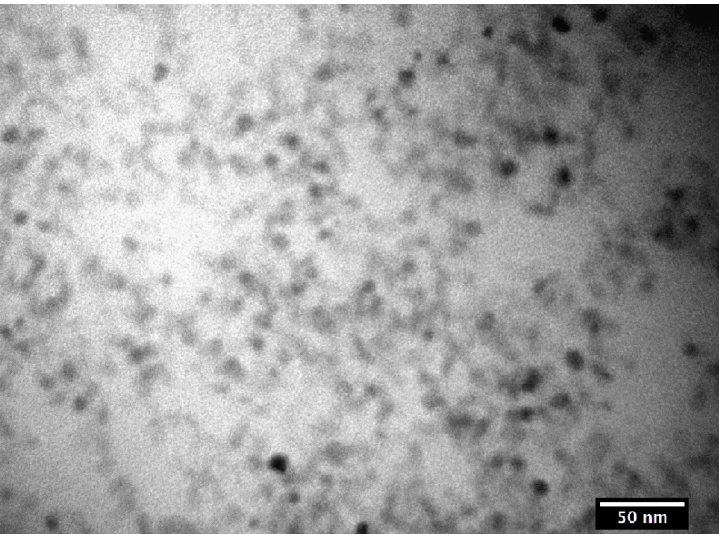
Figure 6. TEM images of (4–5%) NPPMDS in modified Sylgard reticulated matrix (scale bar: 100